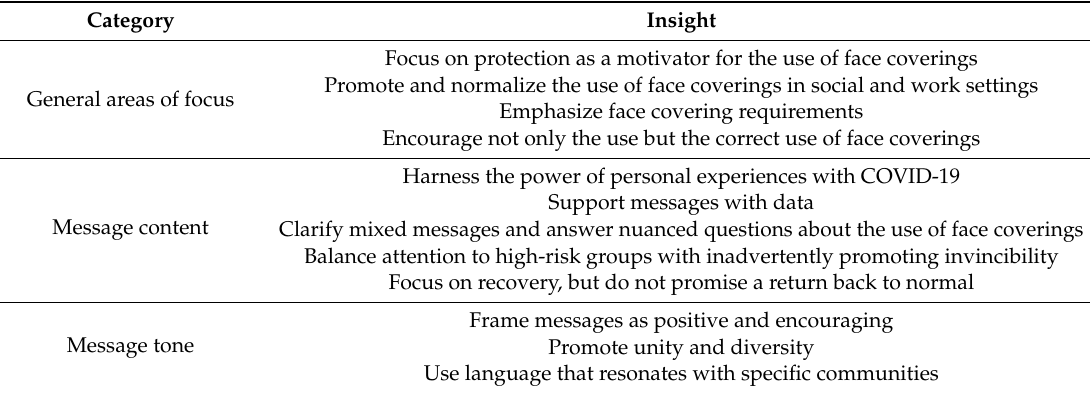
Table 4. Insights for messaging strategies informed by focus groups with North Carolina